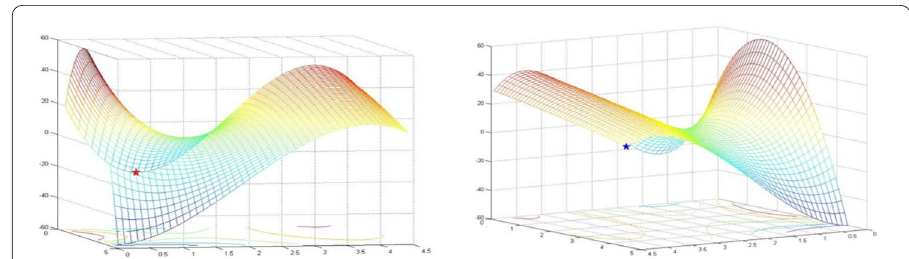
Figure 1 Two local solutions for Example 11 obtained by the proposed algorithm